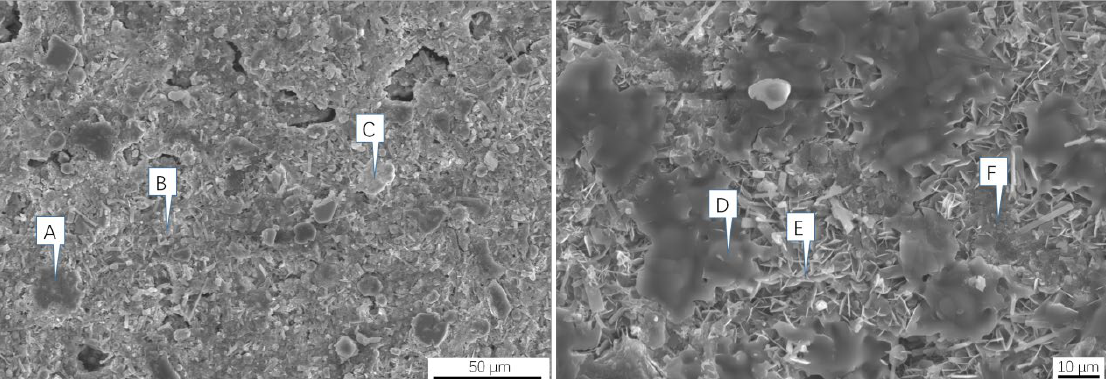
Figure 6. SEM images of the coagulum. Table 2. Element composition in marked regions of Figure 6 (mol%).